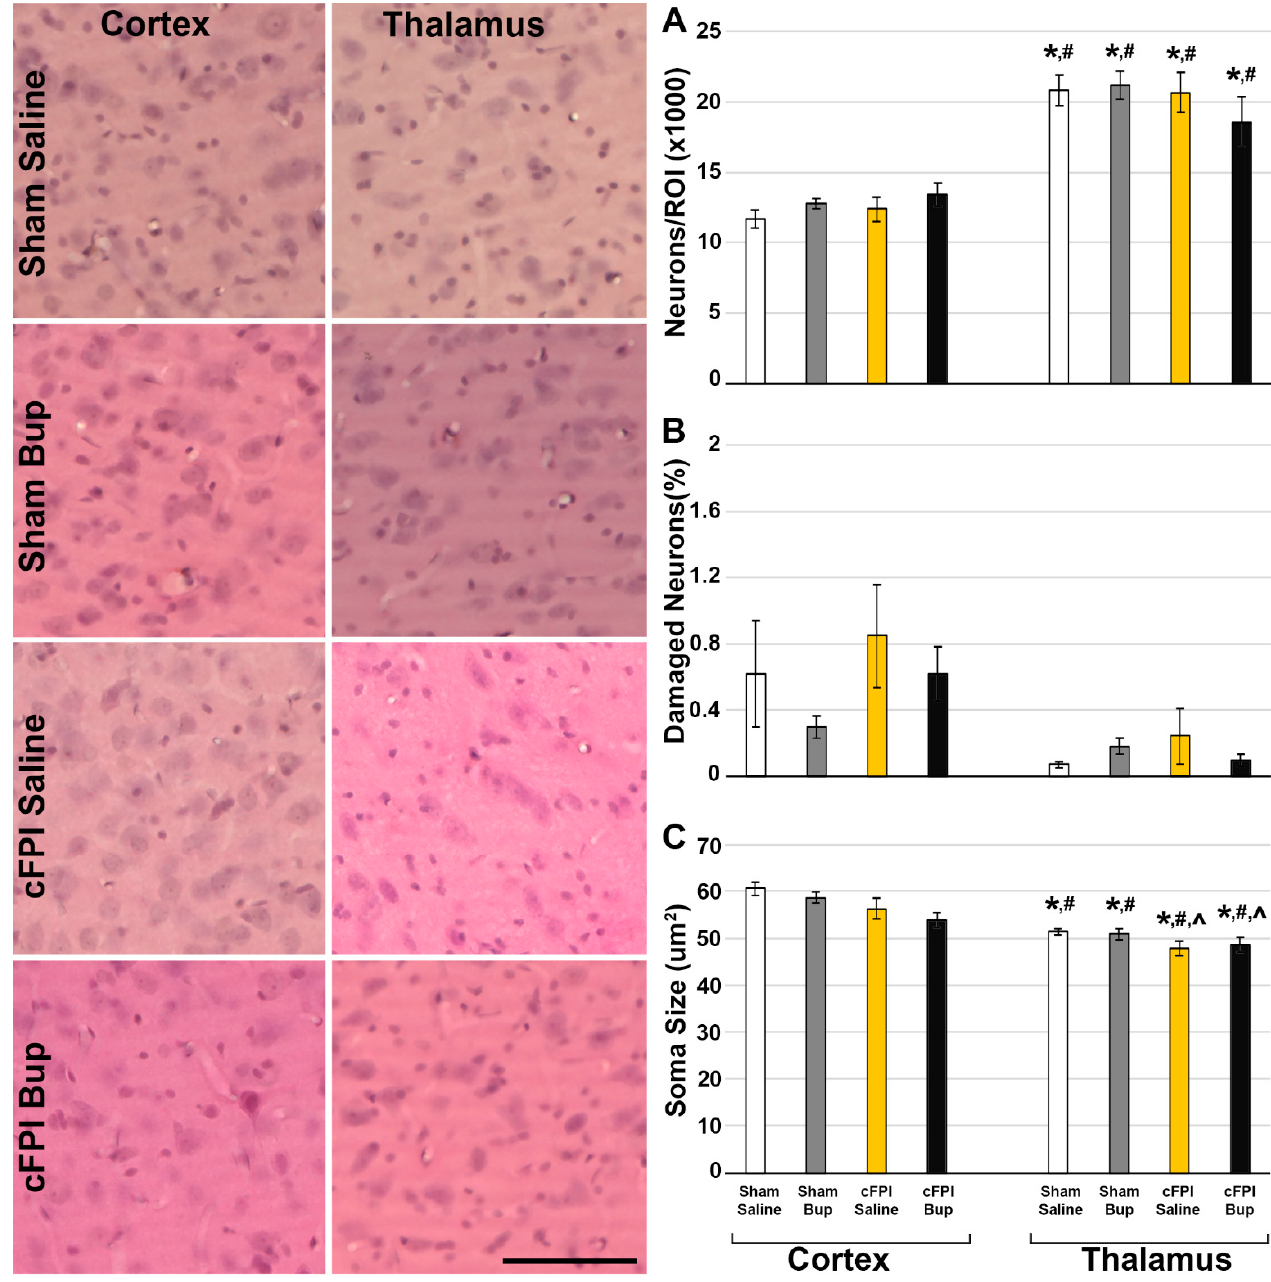
Figure 2. Cell number, damage, and size was not altered by Bup-SR-Lab (Bup) treatment at 4w post sham or central fluid percussion injury (cFPI). Representative photomicrographs of the cortex or thalamus from animals treated with saline or Bup following sham or cFPI and labeled with hematoxylin and eosin (H&E). ( A – C ) Corresponding bar graphs depicting ( A ) the total number of neurons/region of interest (ROI) in the thousands, ( B ) percent of total H&E stained neurons exhibiting pycnotic nuclei or eosinophilic cytoplasm indicative of damage for the cortex and thalamus, and ( C ) Soma size. n = 6 rats/group. Mean ± SEM. Scale = 100 μ m. * p < 0.05 compared to sham saline cortex, # p < 0.05 compared to sham Bup cortex, ^ p < 0.05 compared to cFPI saline cortex.